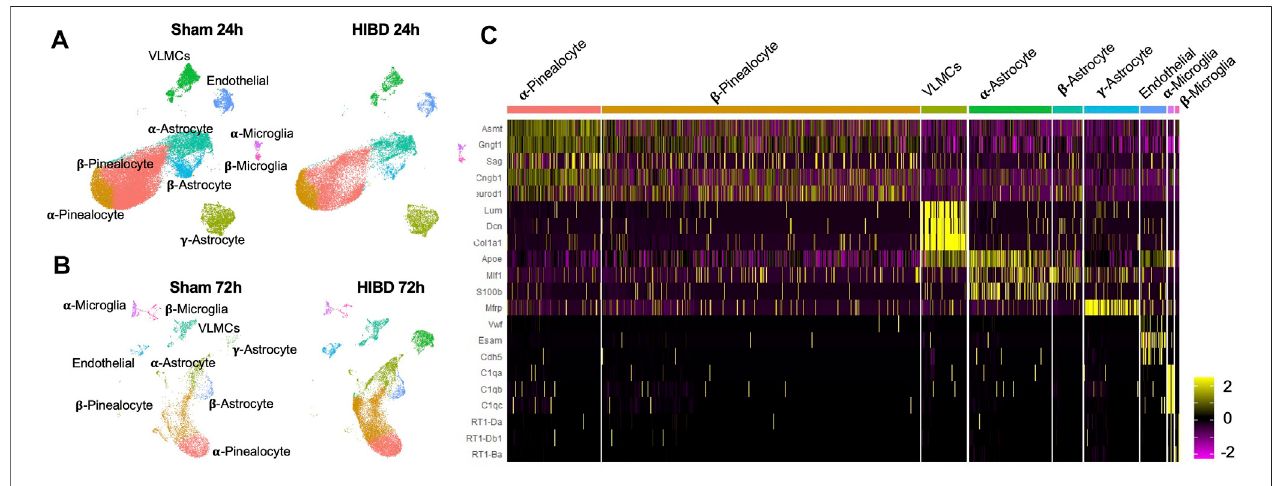
FIGURE 1 | Transcriptomic characterization of pineal gland at single cell level post neonatal HIBD (A,B) Uniform Manifold Approximation and Projection (UMAP) visualizationofratpinealglandcellscollectedat24and72 hpostshamorneonatalHIBD (C) Heatmapofexpressionvaluesofcharacteristicgenesfordistinctcelltypes.